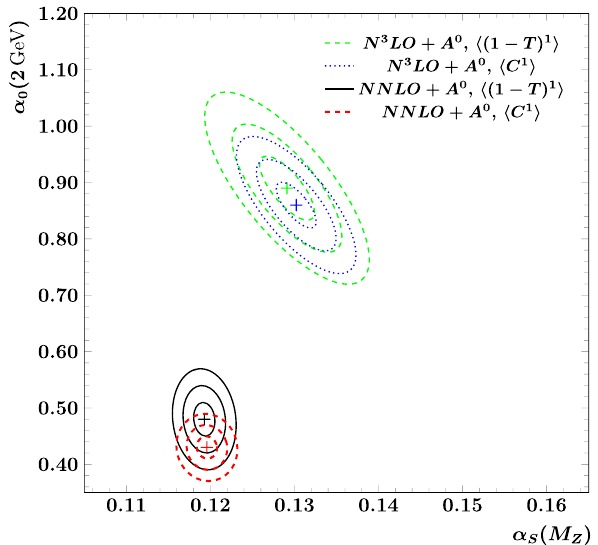
Fig. 4 Thevaluesof α S ( M Z ) and α 0 ( 2GeV ) obtainedfromtheNNLO and N 3 LO fits with analytic hadronization model in the A 0 scheme. The contours correspond to 1-, 2- and 3 standard deviations obtained in the fit. Systematic uncertainties are not